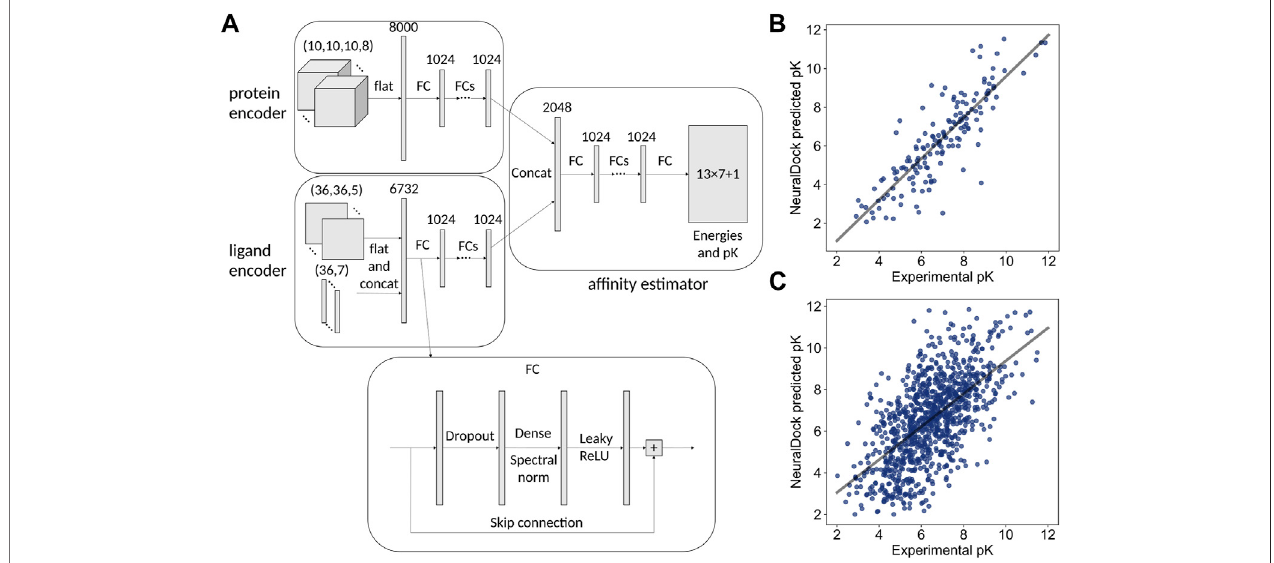
FIGURE 1 | The neural network architecture on the left and performance comparison with MedusaDock on the right. (A) Inputs, hidden layers, and outputs are shown for the architecture. The protein pocket is fl attened and fed into a subnetwork, and the ligand is processed similarly. The outputs of the two subnetworks are concatenatedandfedintoanothersubnetwork,whichoutputs13×7+1valuesrepresentingthe7summarystatisticsofthe13energiesoutputbyMedusaDock,aswell asthepKoftheprotein-ligandpair.ThestructureofeachFClayerisshownatthebottom. (B) The45millionparameterNeuralDocknetworkachievesclass-leading performance on the PDBbind 2013 core set ( r = 0.85, p < 0.0001). (C) The 45 million parameter NeuralDock network achieves good agreement with experimentally determined pK on the validation set ( r = 0.62, p <